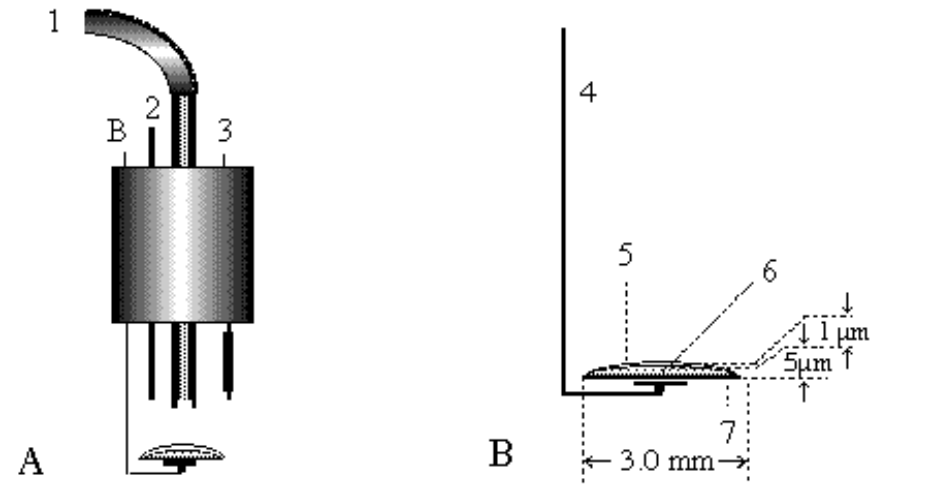
Figure 2. Configuration profile of the sensor probe (A) and Pt electrode coated with chitosan encapsulated Ru (II) complex/silica gel membrane (B). 1. optical fiber;